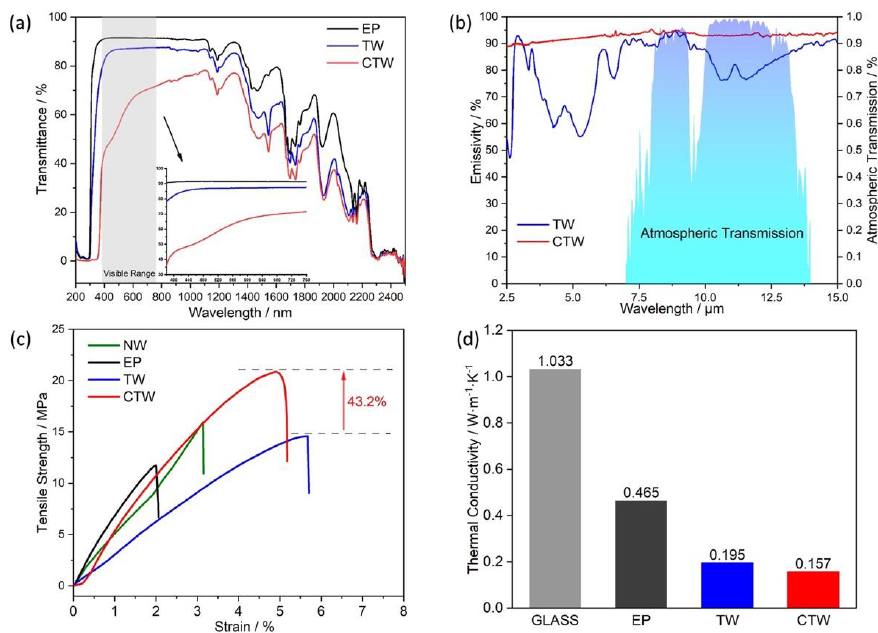
Figure 25. ( a ) Transmittance vs. wavelength curves of cured epoxy resin (EP), uncoated transparent wood (TW), and ZnO-coated transparent wood (CTW); ( b ) emissivity spectrum of TW and CTW within the long-wavelength infrared region; ( c ) stress – strain curves of natural wood (NW), EP, TW, and CTW; ( d ) thermal conductivity of glass, EP, TW, and CTW. Reprinted with permission from [42], copyright 2022, Elsevier.